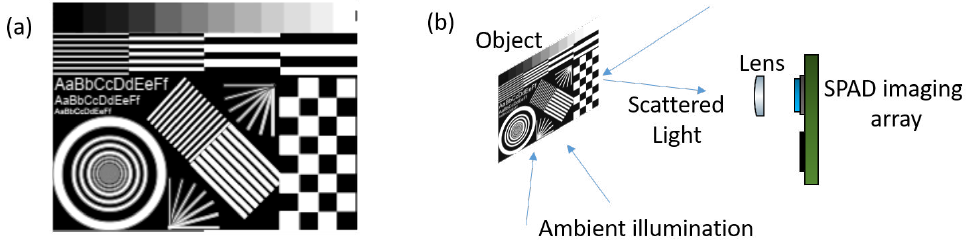
Figure 1. ( a ) Electronic version of the test target used for the work presented here. ( b ) Optical measurement setup with ambient illumination of the test target imaged by a lens coupled SPAD array.